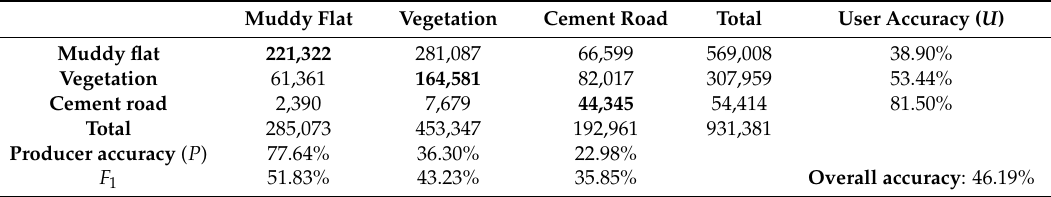
Table 7. Confusion matrix of classification by distance-corrected intensity